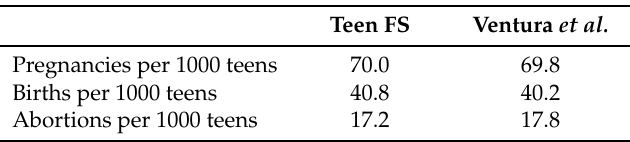
Table 1. Pregnancy and pregnancy outcome rates,